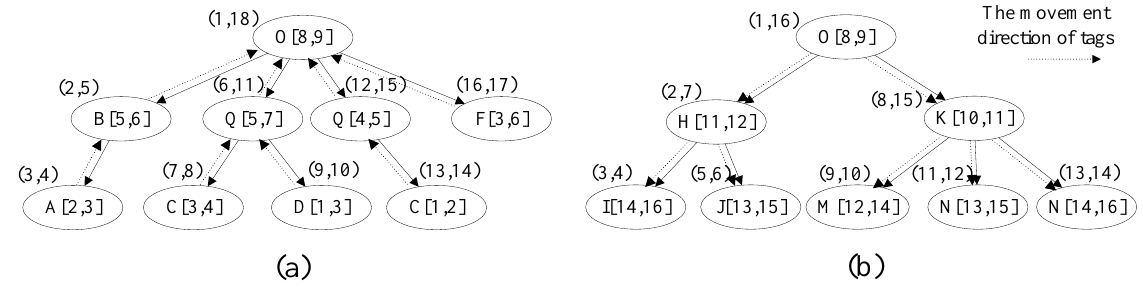
Figure 4. Time tree. ( a ) The backward time tree; ( b ) The forward time